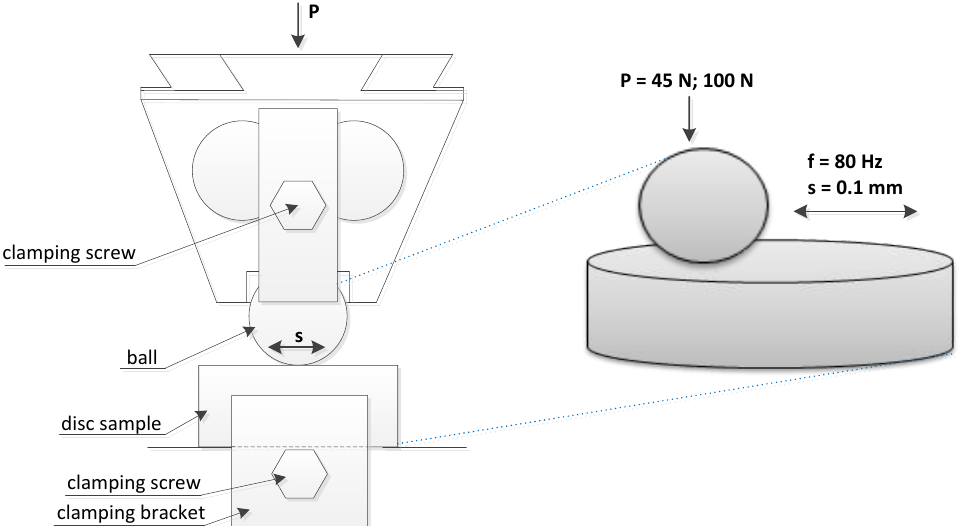
Figure 1. Scheme of the